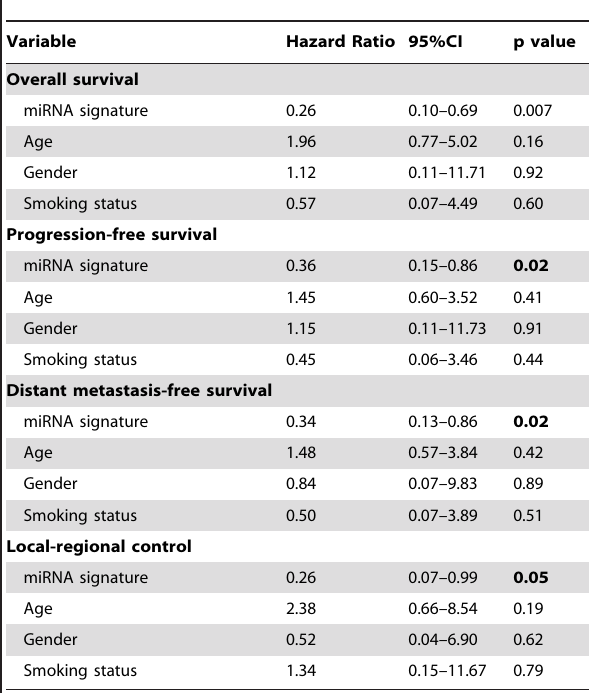
Figure 4. Kaplan-Meier analyses of overall survival (OS), progression-free survival (PFS), distant metastasisfree survival (DMFS) and local-regional control (LRC) according to the microRNA signature in the testing data set (40 SCLC patients). doi:10.1371/journal.pone.0091388.g004 Table 3. Multivariate Cox regression analysis of miRNA signature and survival in the testing set (N